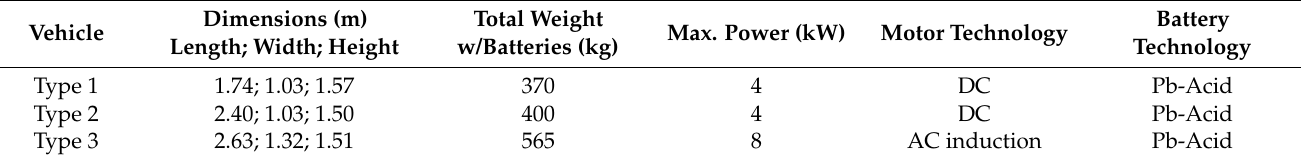
Table 1. Specification of test